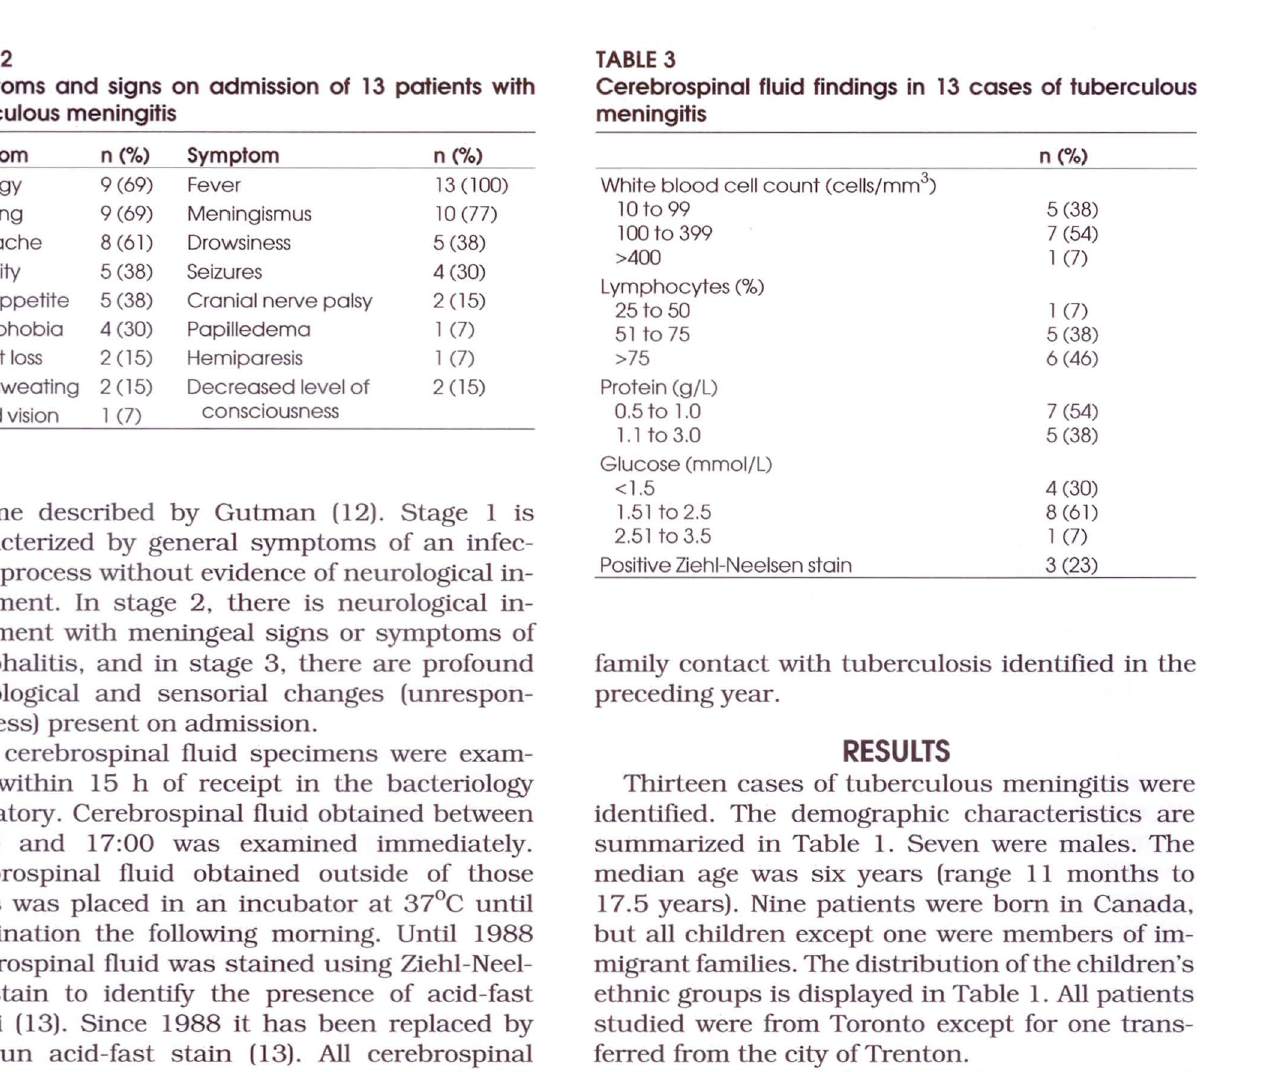
Cerebrospinal fluid findings in 13 cases of